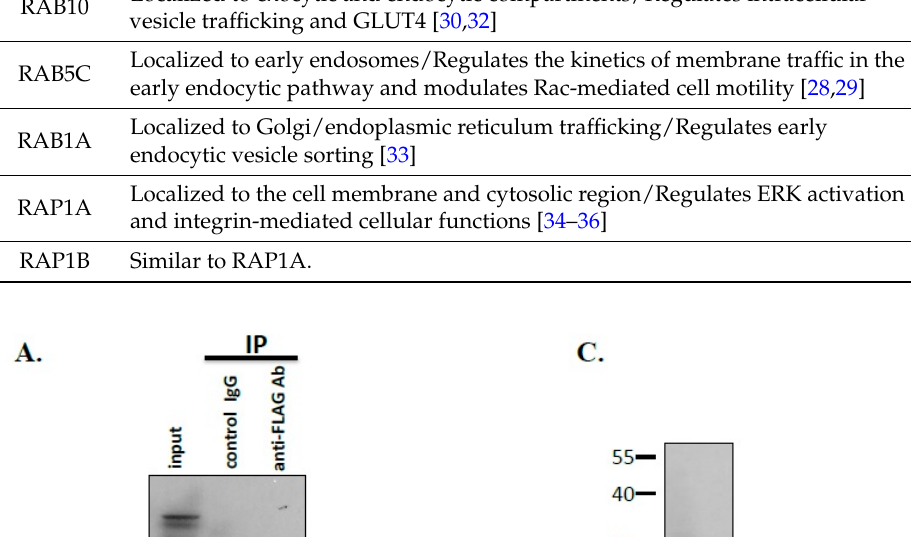
Table 1. Identification of possible interactors of MGCRABGAP through